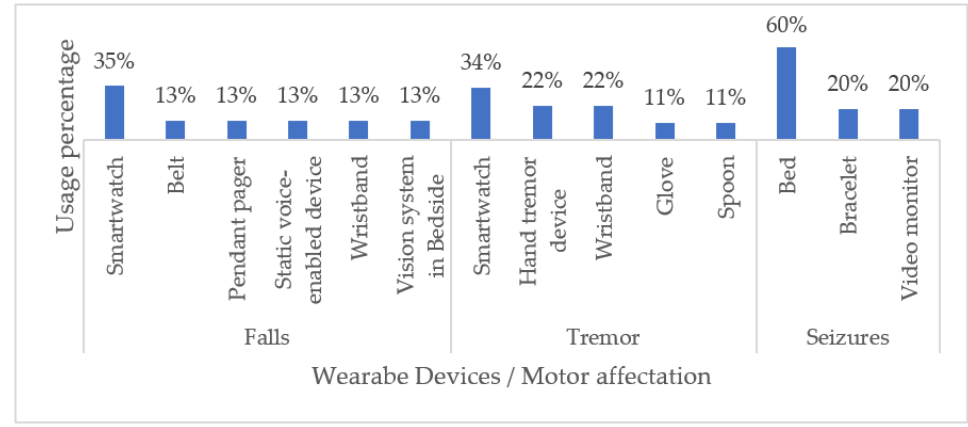
Figure 5. Classification of Commercial Wearable Devices by NDD-Related Motor Disabilities.